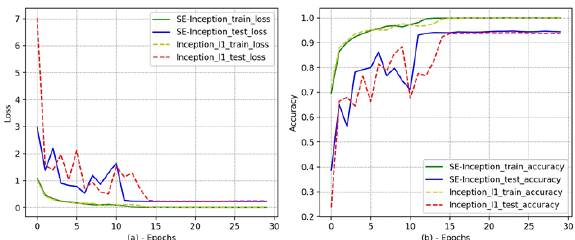
Figure 8. Inception and SE-Inception Training on AID